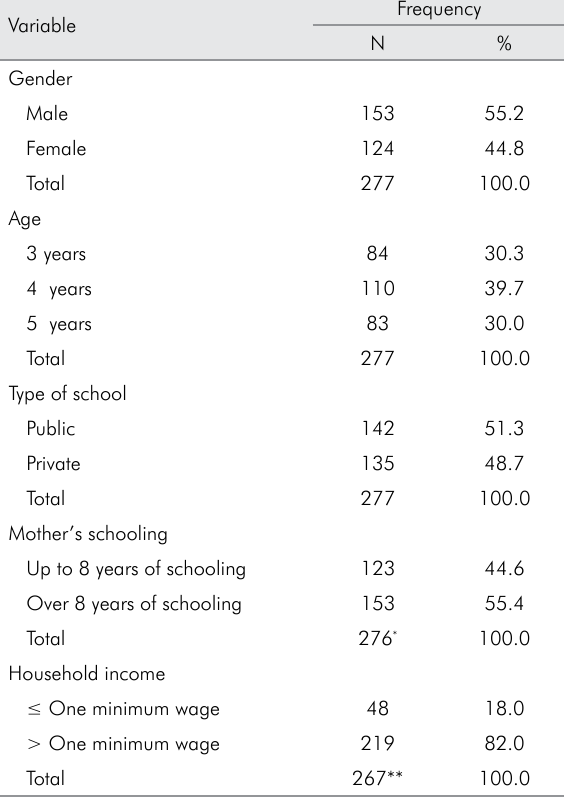
Table 1. Frequency distribution of preschool children ac- cording to gender, age, type of school, mother’s schooling and monthly family